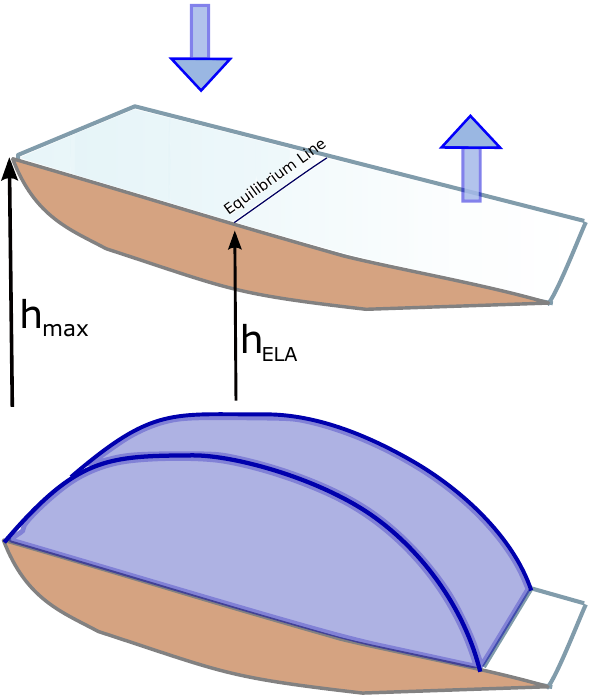
Fig. 8. Schematic view of the equilibrium shape of a glacier on an incline with snowfall and melting. The mass-balance distribution is linear with altitude. Top panel: initial configuration with no ice. Bottom panel: equilibrium shape of the glacier .